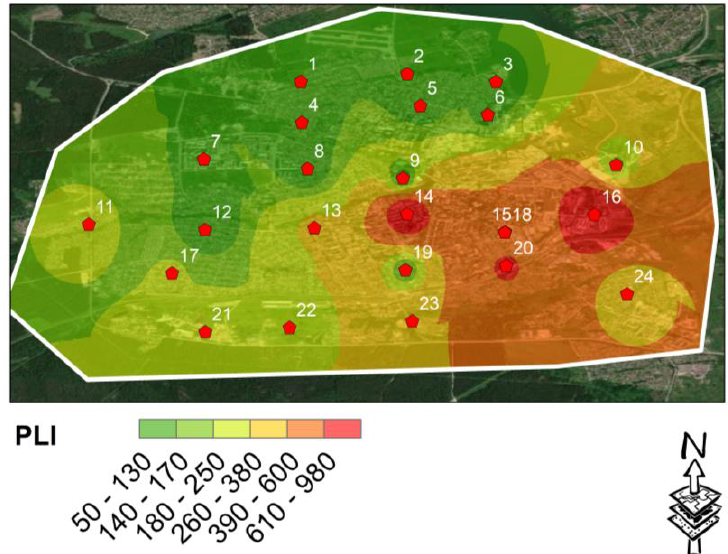
Land 2023 , 12 , x FOR PEER REVIEW Figure 5. The spatial distribution of PLI in the studied city. Figure 5. The spatial distribution of PLI in the studied city.